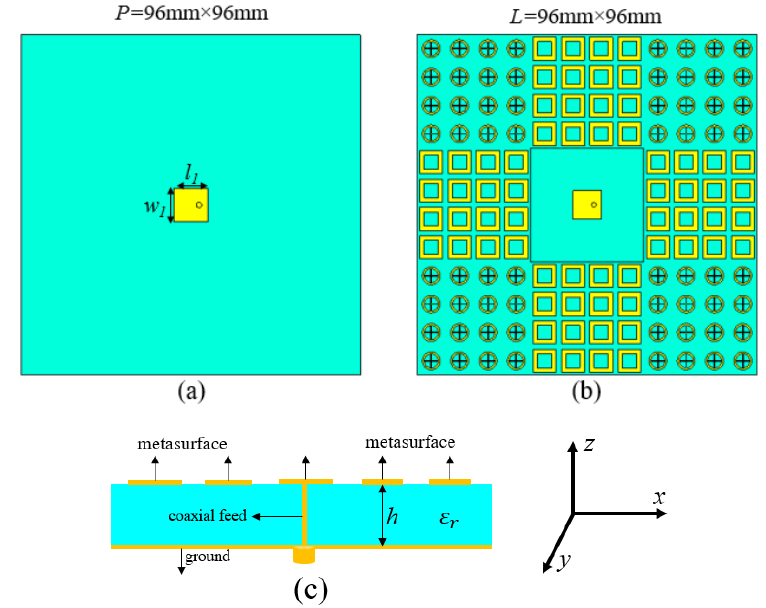
Figure 4. Structure and configuration of reference and proposed antennas. ( a ) The front outlook of the reference antenna. ( b ) The front outlook of the proposed metasurface chessboard with the antenna. ( c ) General configuration of the proposed prototype.